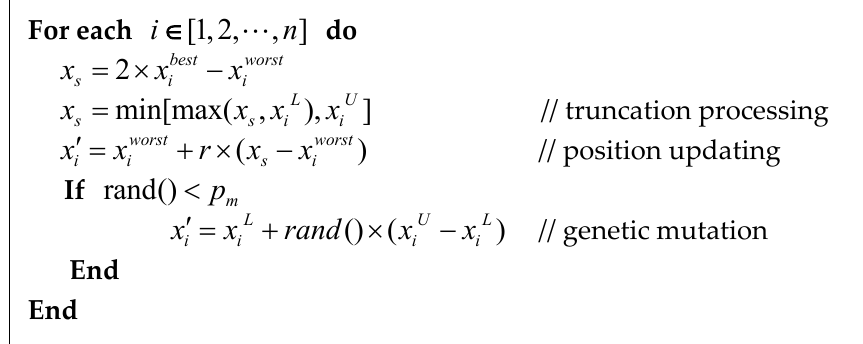
Figure 2. Generating a new harmony by NGHS algorithm.